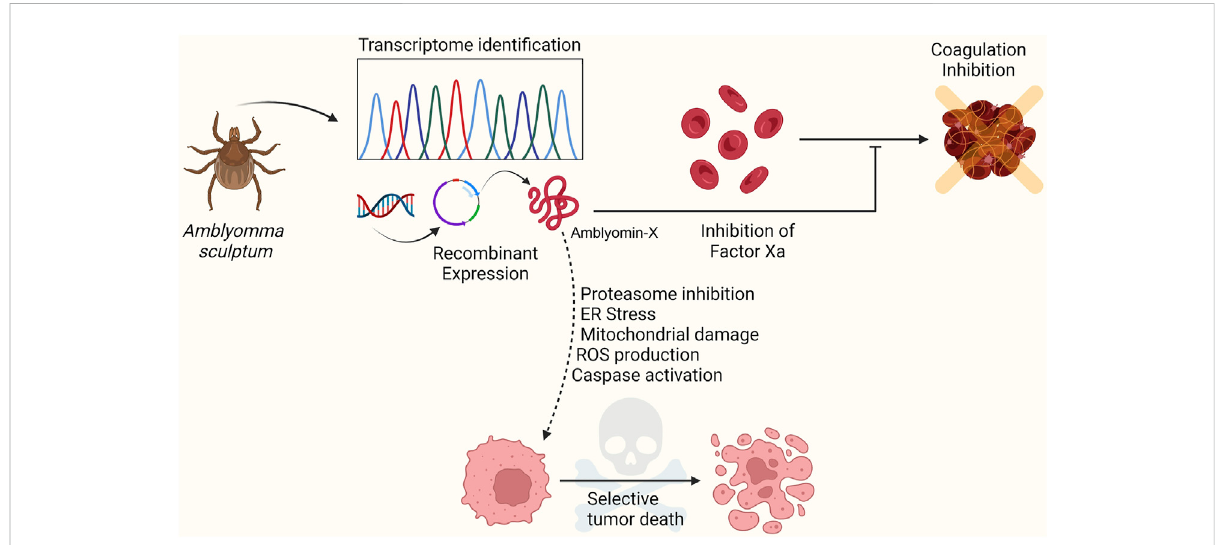
Thesalivaryglandtranscriptomeofthe Amblyommasculptum tickwascharacterizedandanalyzedbyexpressedsequencetags(EST).Thestudy revealed the presence of protein-related transcripts involved in the hemostatic process, especially proteases and inhibitors. A Kunitz-type inhibitor similar to thetissuefactor pathway inhibitor (TFPI)precursorwasidenti fi ed. Thisinhibitor, Amblyomin-X, wasobtained as arecombinantproteinand presentedanticoagulant,antiangiogenic,andantitumorproperties.Furthermore,Amblyomin-Xdemonstratedselectivityfortumorcells.Figure created in